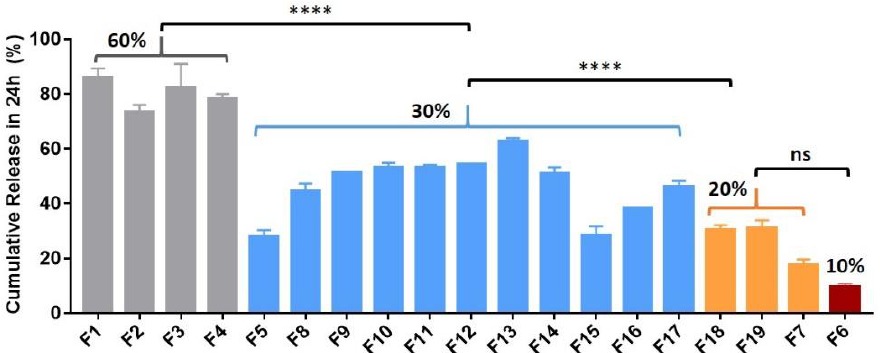
Figure 1. Mean ( ± SEM) in vitro ketamine percentage of cumulative release in 24 h for a range of formulations ( n = 3). Reducing the ketamine payload from 60% to 30% and from 30% to 10–20% reduced the burst effect (****, p < 0.0001). One-way ANOVA followed by the Bonferroni test.